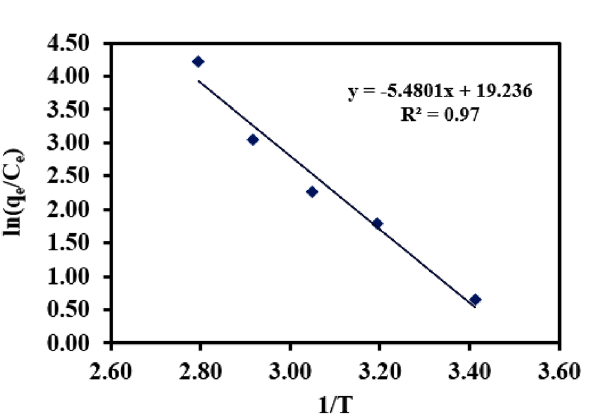
Figure 11. Linear plot of ln(q e /C e ) versus 1/T.